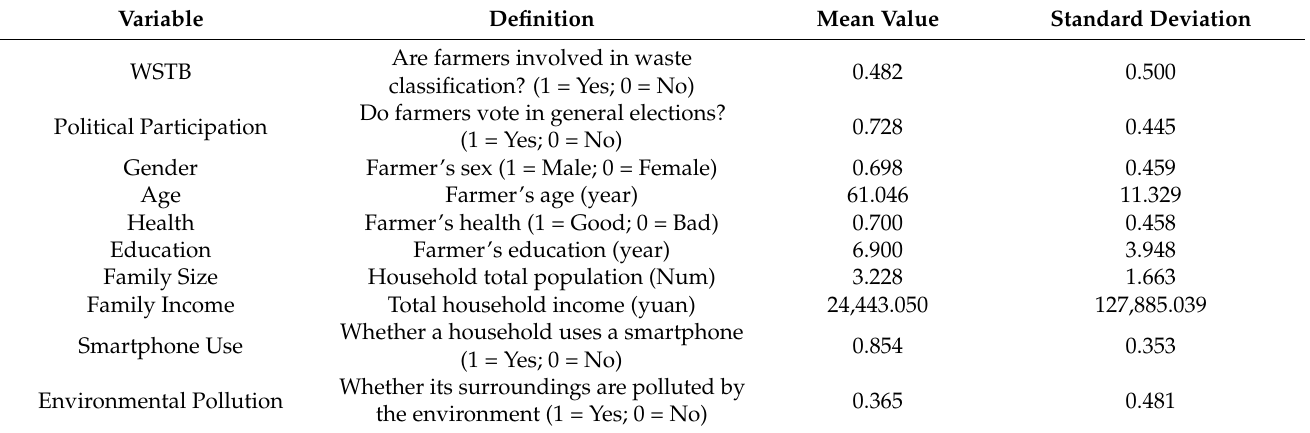
Table 1. The definition and data description of the variables in the